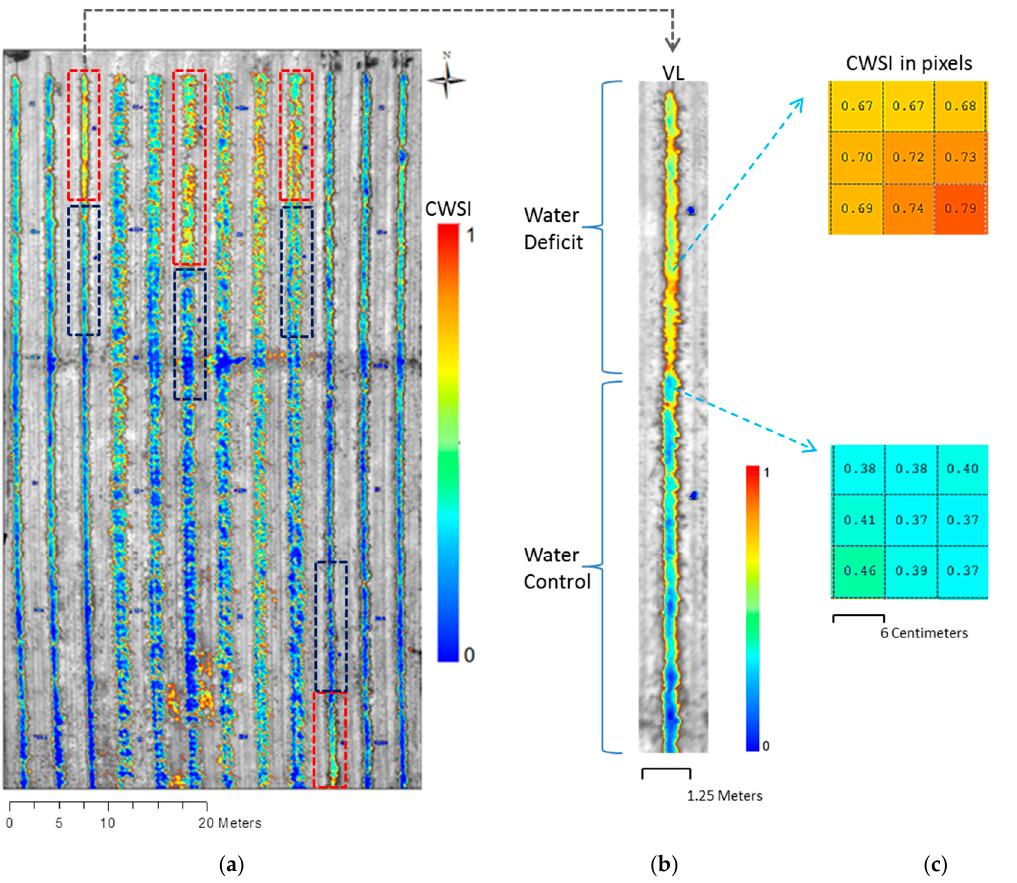
Figure 6. ( a ) Adaptive Crop Water Stress Index (CWSI) map derived from UAV remote sensing using thermal infrared images. Four dotted rectangles in red represent the area of deficit irrigation treatments and four dotted rectangles in blue the full irrigation of control treatments; ( b ) example of CWSI map depicting water deficit and control treatment groups for Nectarine VL (Vertical Leader); ( c ) examples of the pixel-level resolution of CWSI for T1 (in deficit) and T2 (in control) sampled